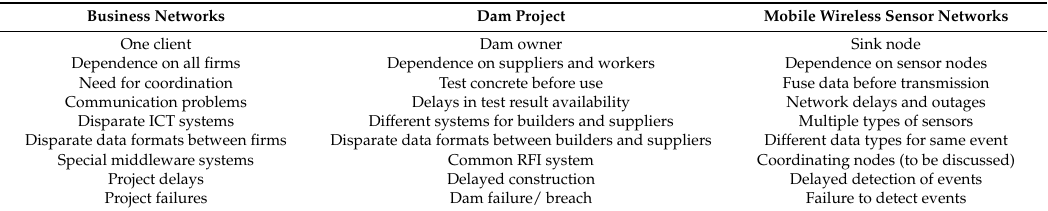
Table 1. Selected